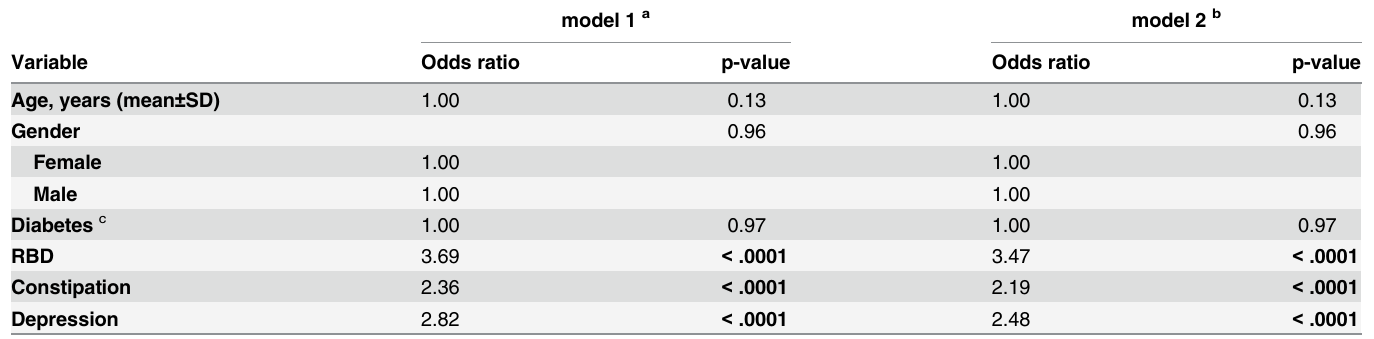
Table 3. Odds ratio of depression/constipation/RBD associated with PD in logistic regression analysis.